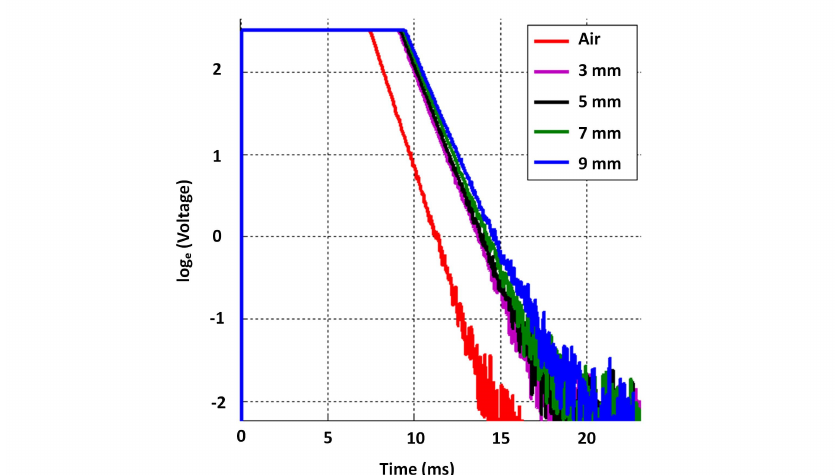
Figure 17. Sensitivity to low thickness at the default excitation amplitude (10 V) at 14 mm lift-off; sharp rising edges of signals are not discriminable in the ms time scale and appear to be